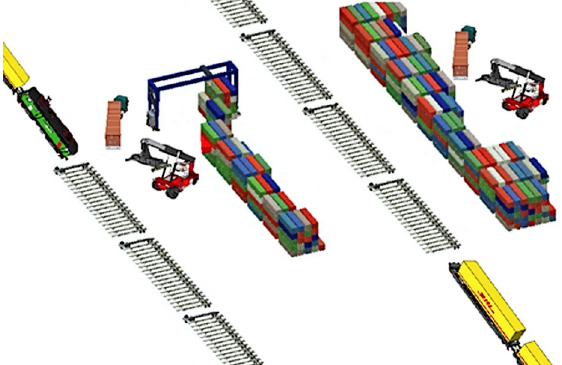
Fig. 1. Horizontal type of handling space